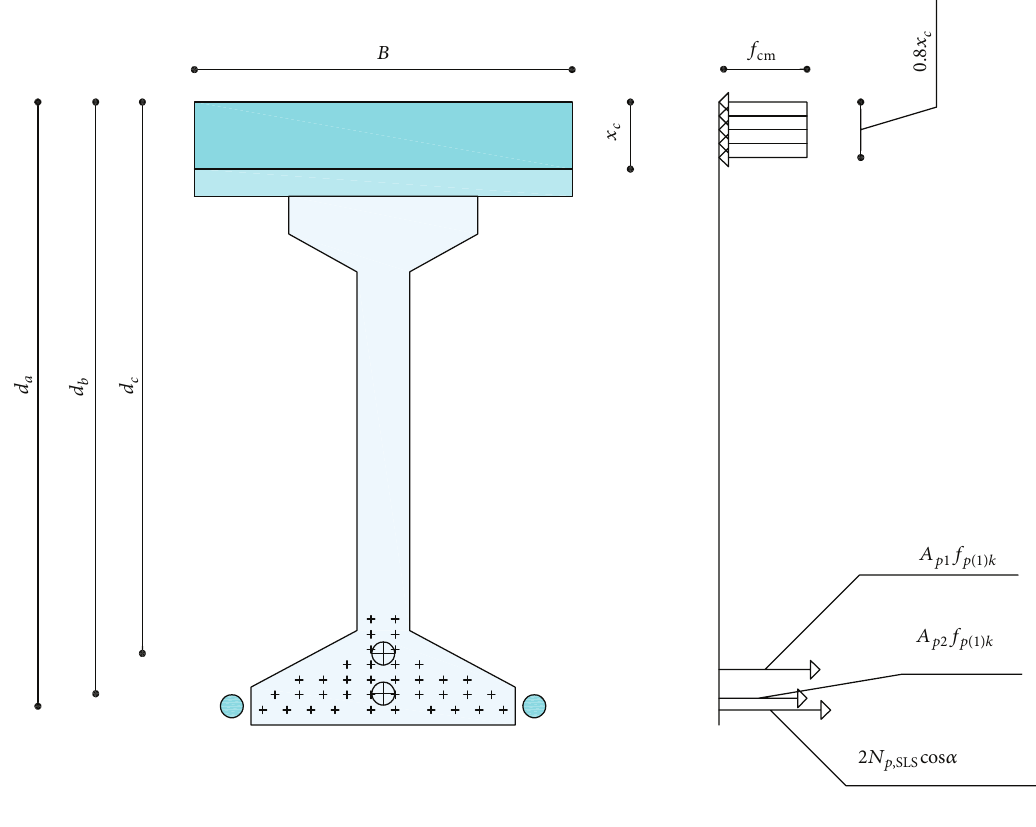
Figure 10: Free-body forces diagram at midspan cross-section of beam.